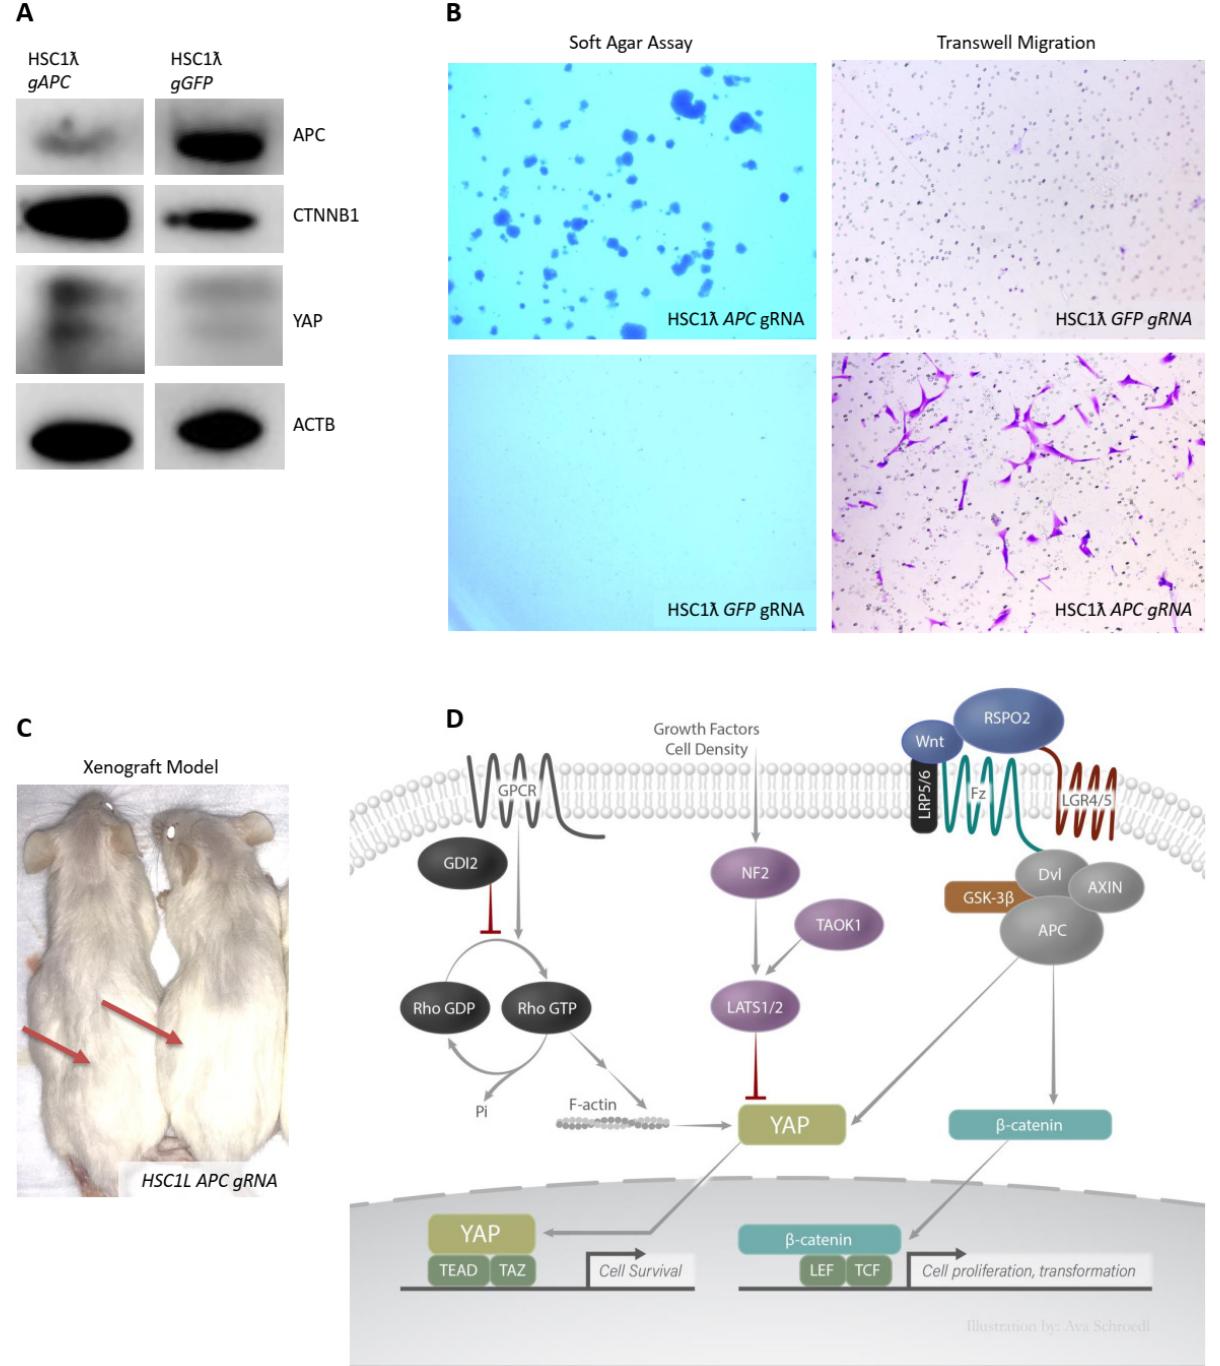
Figure 4. Wnt pathway negative regulator APC is a Schwann cell tumor suppressor gene and multiple pathways converge downstream resulting in Hippo/YAP activation. ( A ) Western blot showing loss of APC via CRISPR/Cas9 and increased YAP1 and CTNNB1 levels. ( B ) Loss of APC results in anchorage-independent growth and cell migration (1.5 × magnification). ( C ) Loss of APC results is tumor formation in NRG xenograft model. ( D ) Diagram summarizing results showing overall Hippo/YAP activation via the loss of multiple tumor suppressor genes that occur in MPNSTs. Wnt, growth factor activity, cell density and Rho pathway(s) activation results in Hippo/YAP pathway activation in